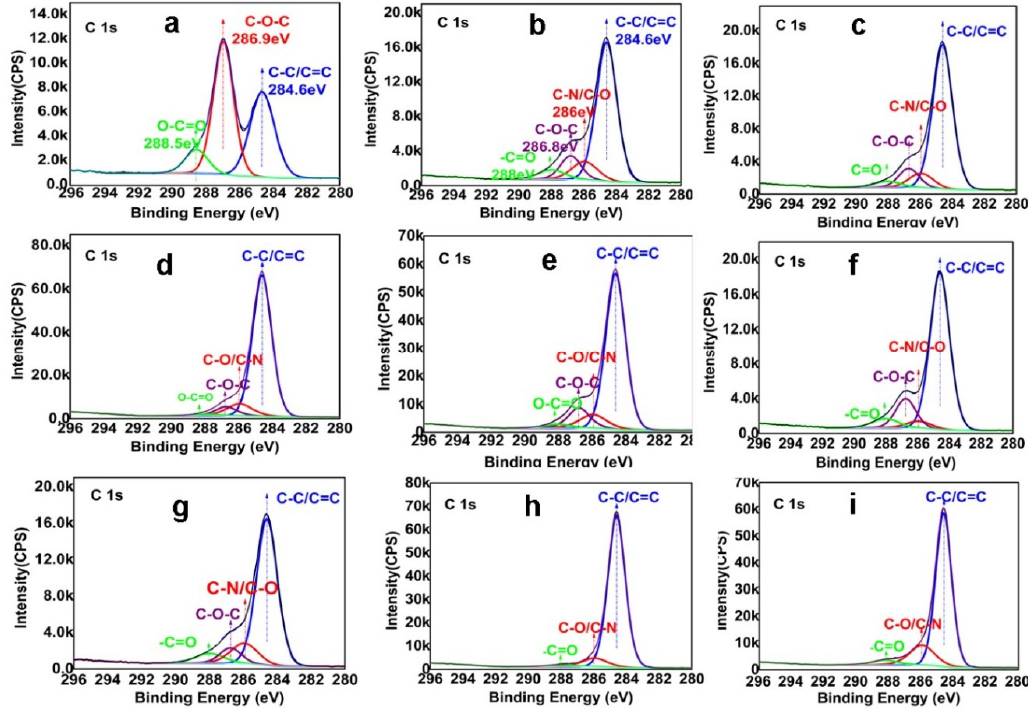
Figure 3. The deconvolution of the peaks in XPS C 1s spectroscopy of GO and RGOs (( a ) GO; ( b ) ORGO at 35 °C, 0.5 h; ( c ) ORGO at 35 °C, 5 h; ( d ) ORGO at 50 °C, 0.5 h; ( e ) ORGO at 50 °C, 5 h; ( f ) ORGO at 80 °C, 0.5 h; ( g ) ORGO at 80 °C, 5 h; ( h ) ORGO at 120 °C, 0.5 h; ( i ) ORGO at 120 °C, 5 h).